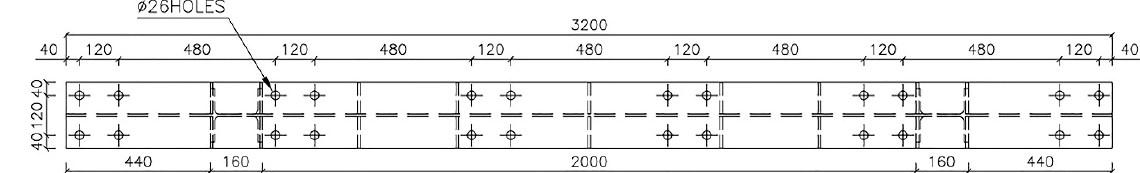
Figure 4. Details of connections.